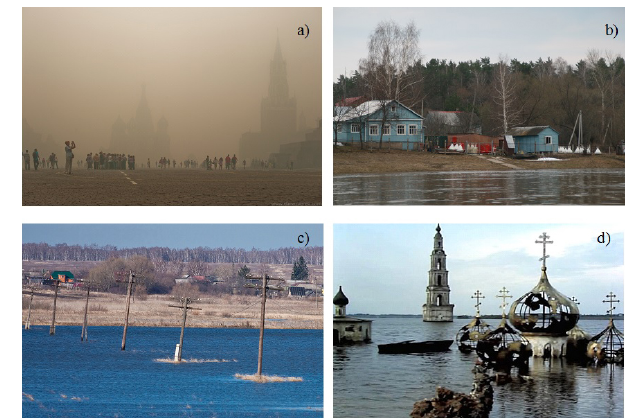
Figure 1. (a) Smog in Moscow, 2010 (D. Zverev’s photo), (b, c) catastrophic flood in 2013 Oka river (N. Frolova’s photo and A. Kamensky’s photo), (d) flooded by Rybinsk Reservoir city Mologa, which came out of the water in 2014 (Y. Rassulin’s photo).